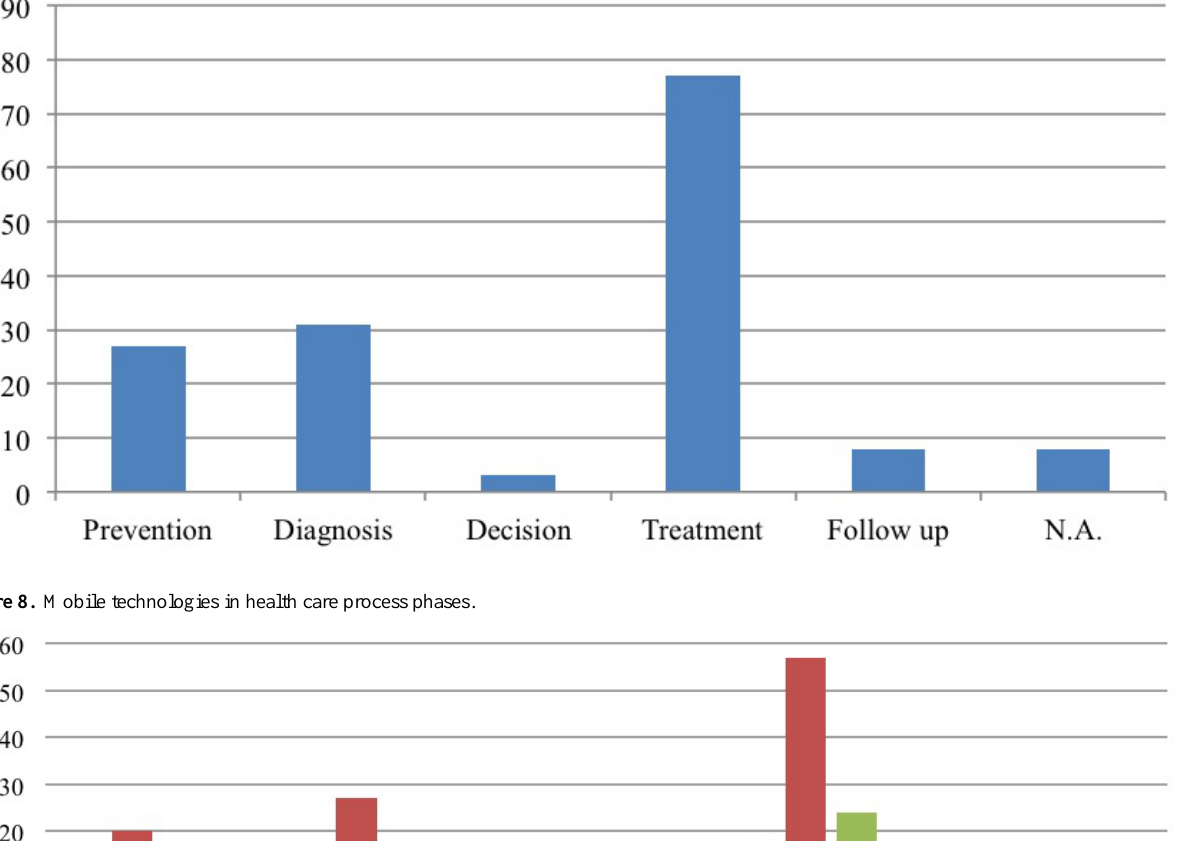
Figure 7. Papers on the different phases of the health care process.